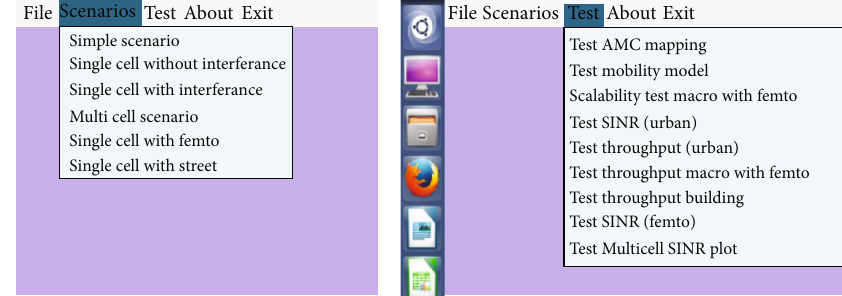
Figure 5: A scenario menu and a testing